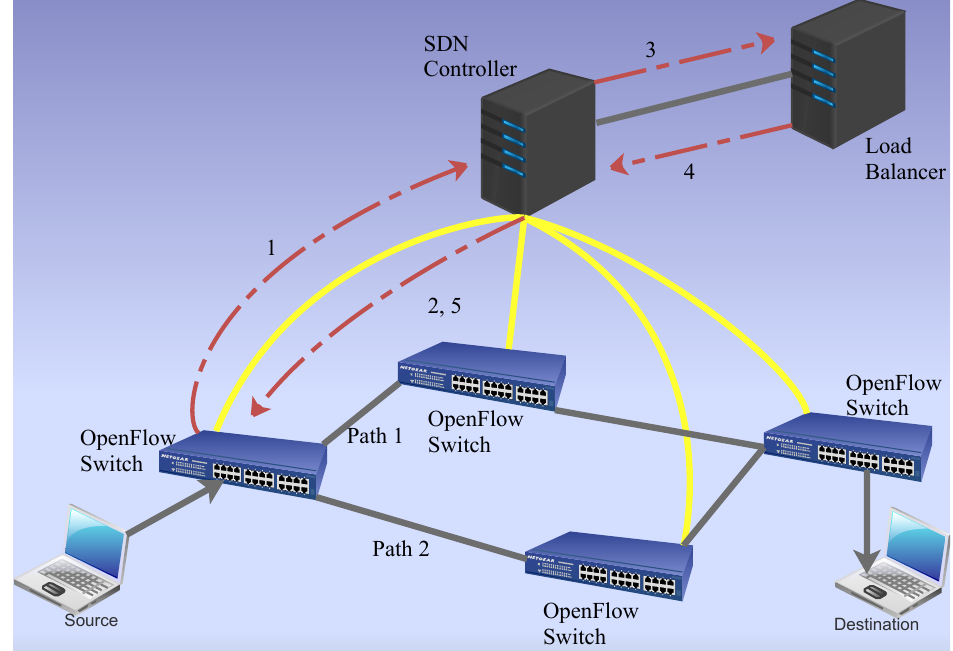
Figure 4. Network architecture for the SDN load balancing